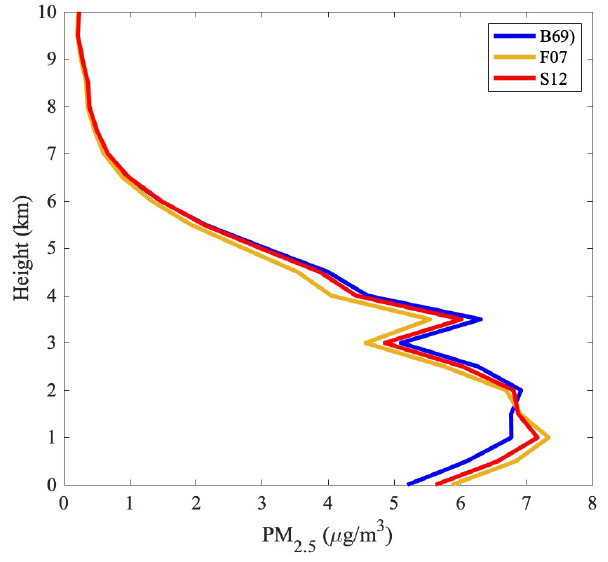
Figure 5. Vertical profile of 2-month average PM 2 . 5 concentration for B69, F07, and S12 in the CONUS